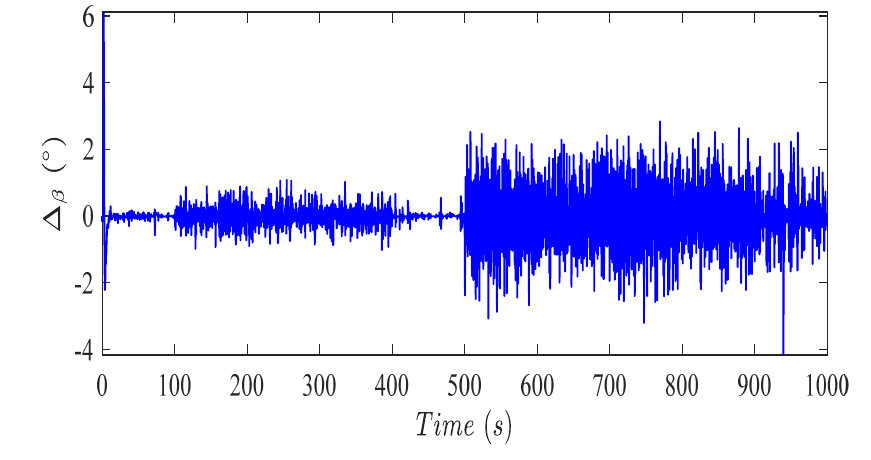
Figure 10. Profile of ∆ β